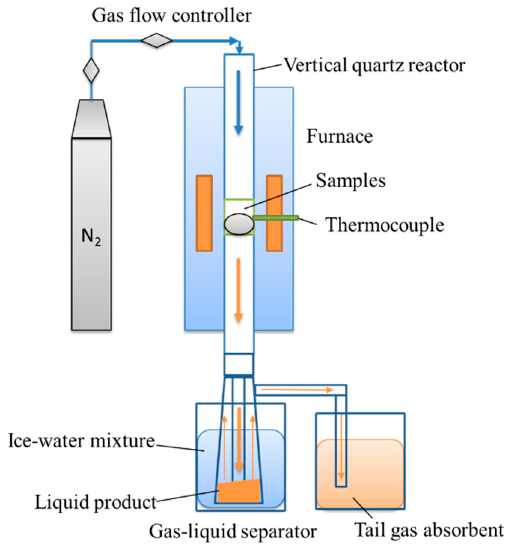
Figure 1. Diagram of the vertical fixed-bed reactor system .